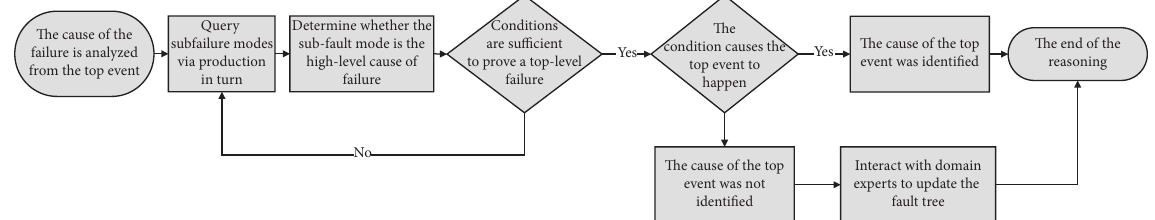
Figure 2: Reasoning process of the fault tree analysis [16].